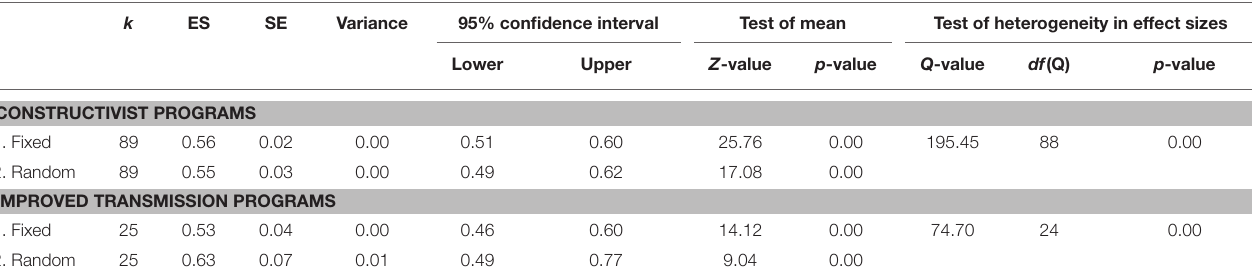
TABLE 2 | Overall effect sizes of constructivist programs and improved transmission programs.